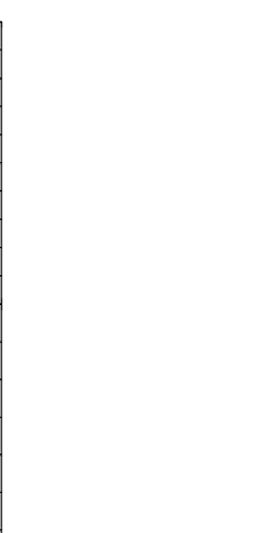
detectors are located around the target at angles 40, 60, 90 and 120 ◦ , detector active area is 10 × 10 mm and its depletion layer thickness is 0.3 mm, 1.512 MeV α beam hit the